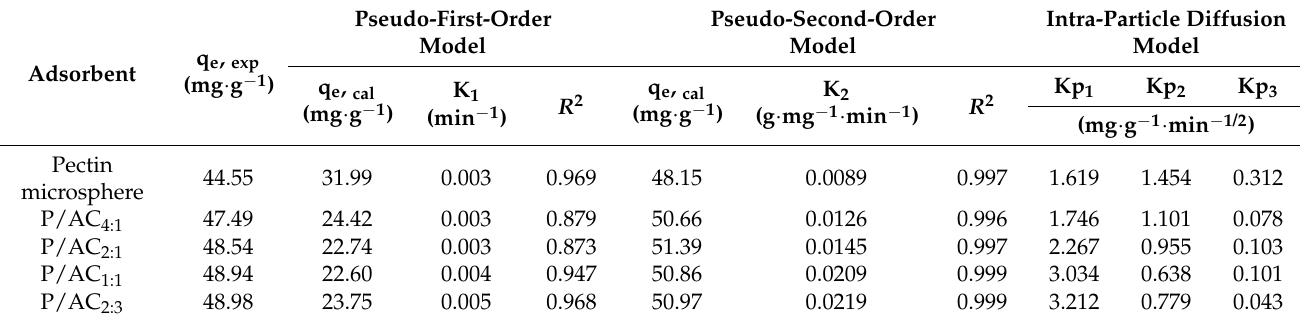
Table 2. Kinetic model parameters of the adsorption of Pb 2+ by